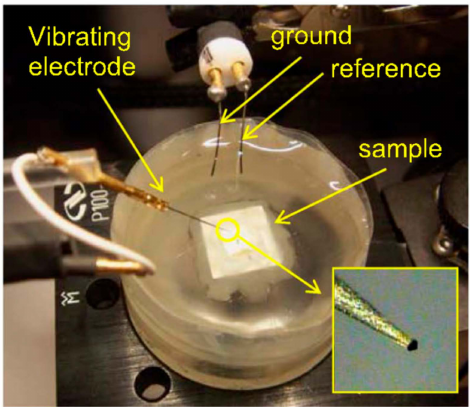
Figure 12. Electrochemical cell setup for scanning vibrating electrode technique (SVET) experiments. Adapted from [65], with permission from © 2017 Electrochemical Society, Inc.